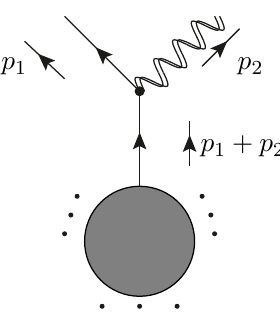
Figure 3 . Double wavy line represents the